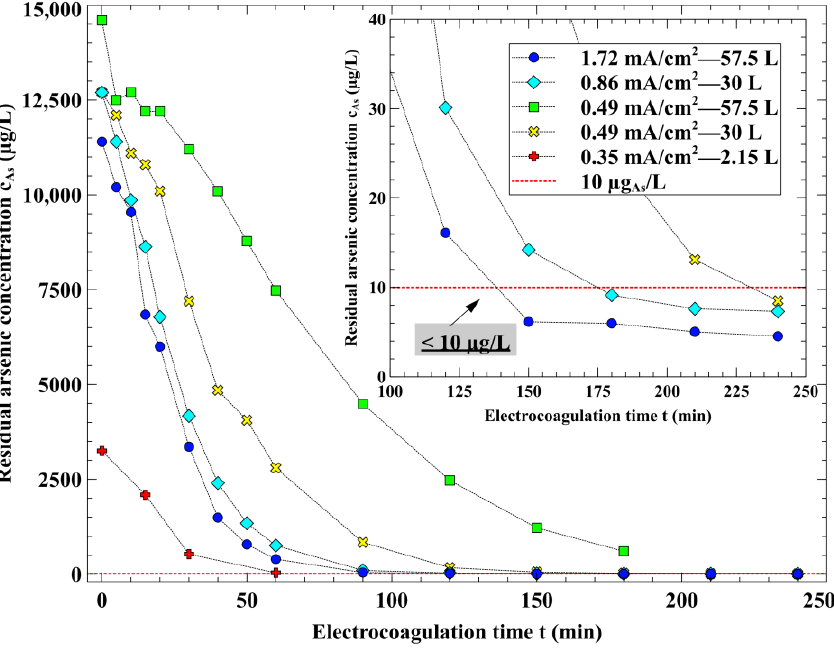
Figure 2. Arsenic concentration reduction as a function of time. Experiments with 0.49 mA/cm 2 — 57.5 L and 0.35 mA/cm 2 — 2.15 L were not run until c As < 10 µg/L.